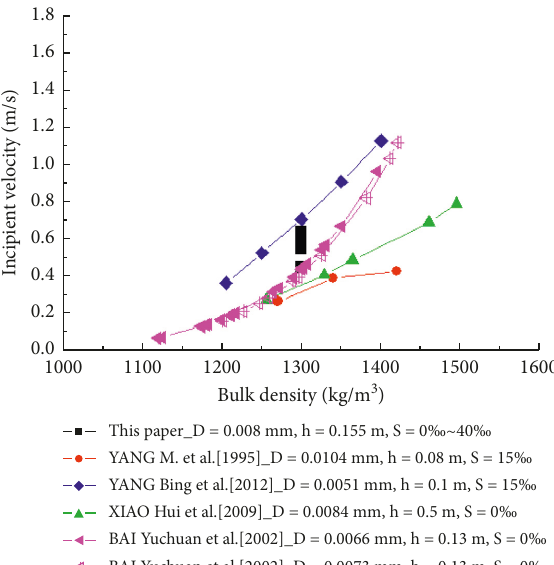
Figure 10: Sediment-moving incipient velocity from lab.